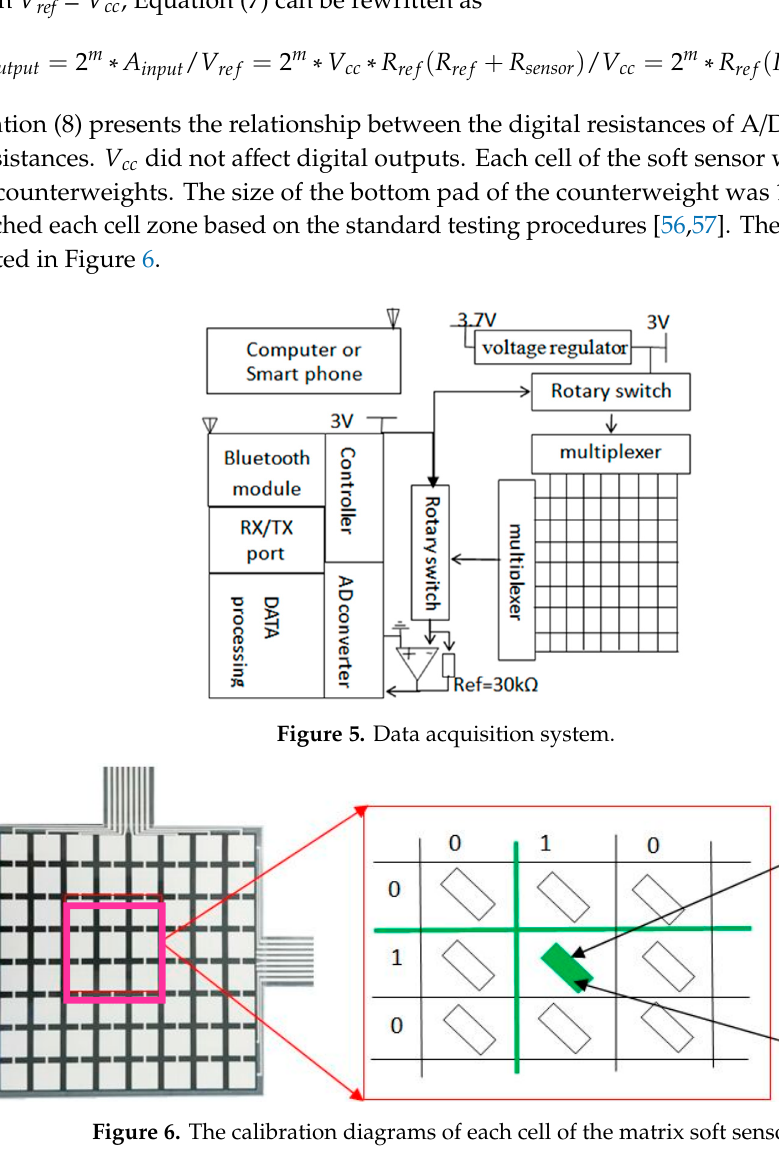
Figure 6. The calibration diagrams of each cell of the matrix soft sensor.